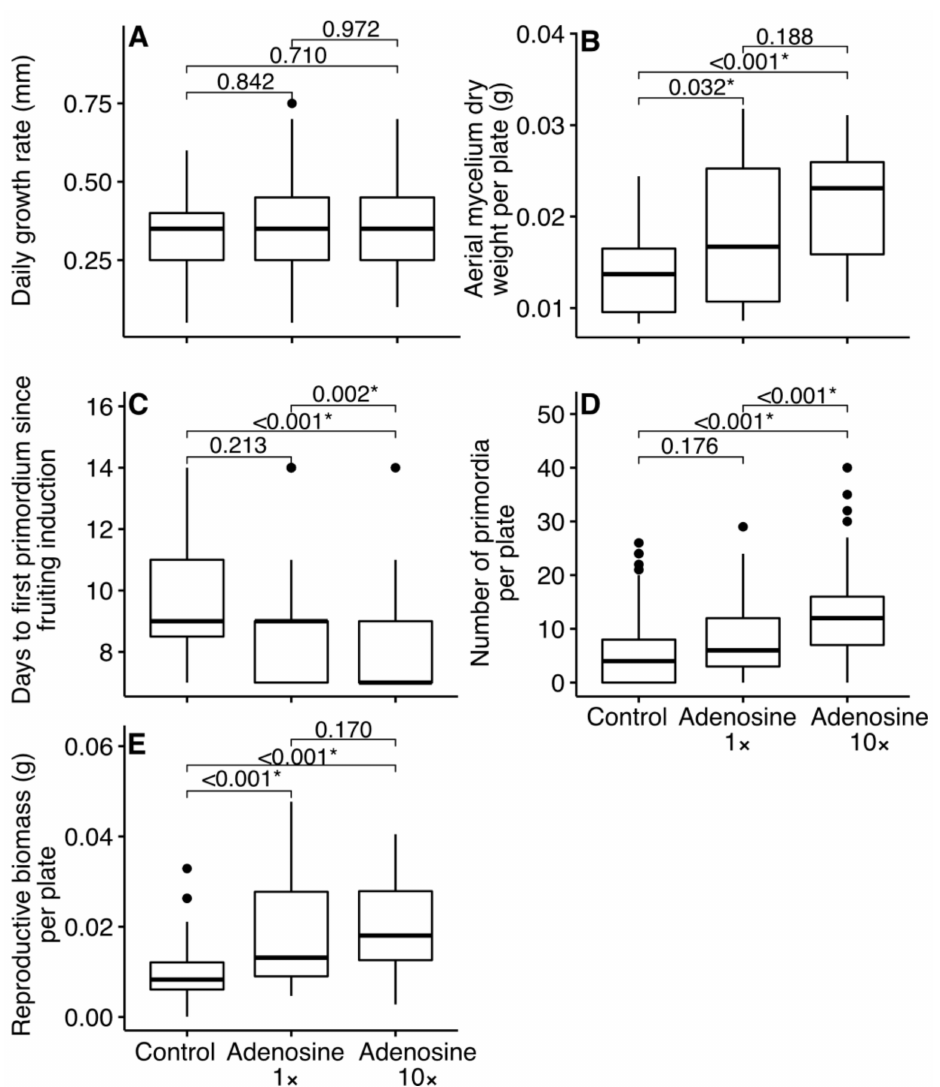
Figure 1. Influence of nitrogen supplementation on fungal vegetative and reproductive biomass of Cyclocybe aegerita AAE-3 ( A ) Mycelial growth rate in mm was measured every day (3 experiments with each 14 replicates). ( B ) Aerial mycelium was harvested when mycelium reached the Petri dish edge and then dry-weighed. ( C ) Days until the first primordium was visible after fruiting inoculation; Petri dishes were checked every second day. ( D ) Total number of primordia produced within 40 days after fruiting induction. ( E ) Dry weight of mature fruit bodies (reproductive biomass). ( C – E ) Three climate chambers and 81 Petri dishes per treatment were employed to acquire the data. To test for significant differences in means between the treatment factors, linear mixed-effects models with random effect on climate chamber were applied. Asterisks indicate significance at alpha level of